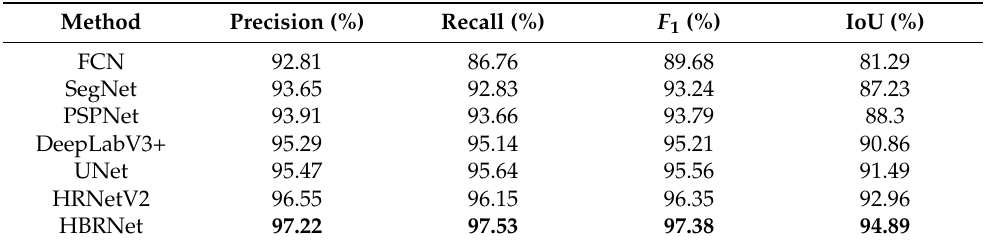
Table 2. Quantitative comparison (%) vs. SOTA methods on the AG dataset. The records in bold represent the best on the test set.